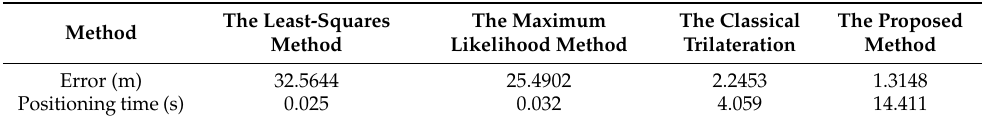
Table 3. The positioning error and positioning time comparison of the methods in the LOS/NLOS mixture